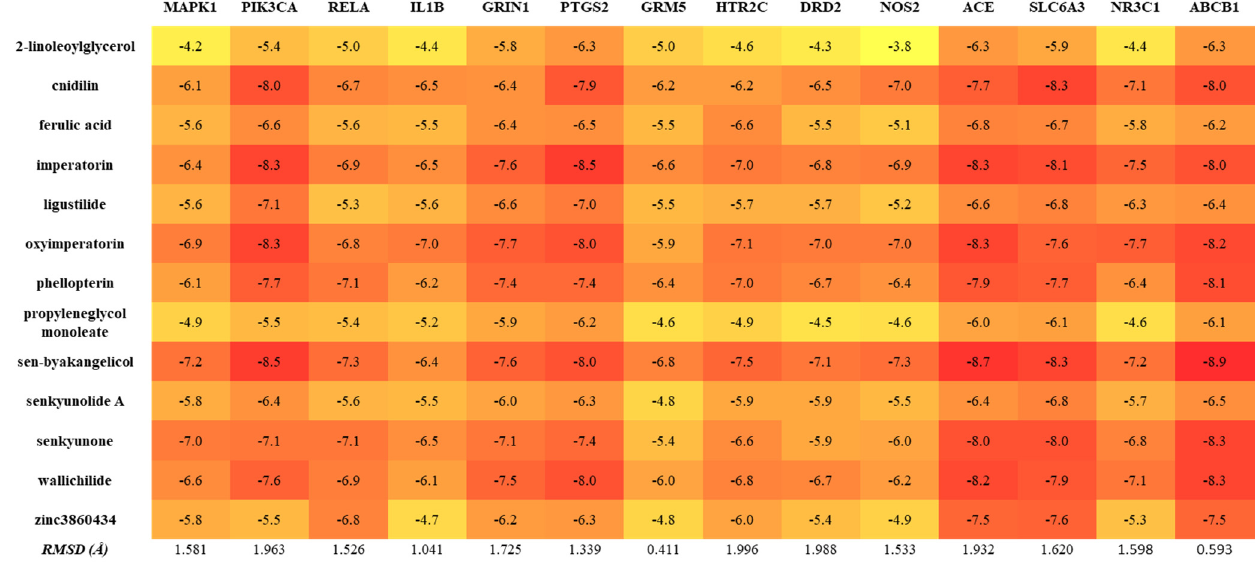
Figure 7. Heatmap of binding score (kcal.mol − 1 ) between compound and protein target in the molecular docking study. The RMSD values below 2.0 Å indicate the docking results are acceptable.